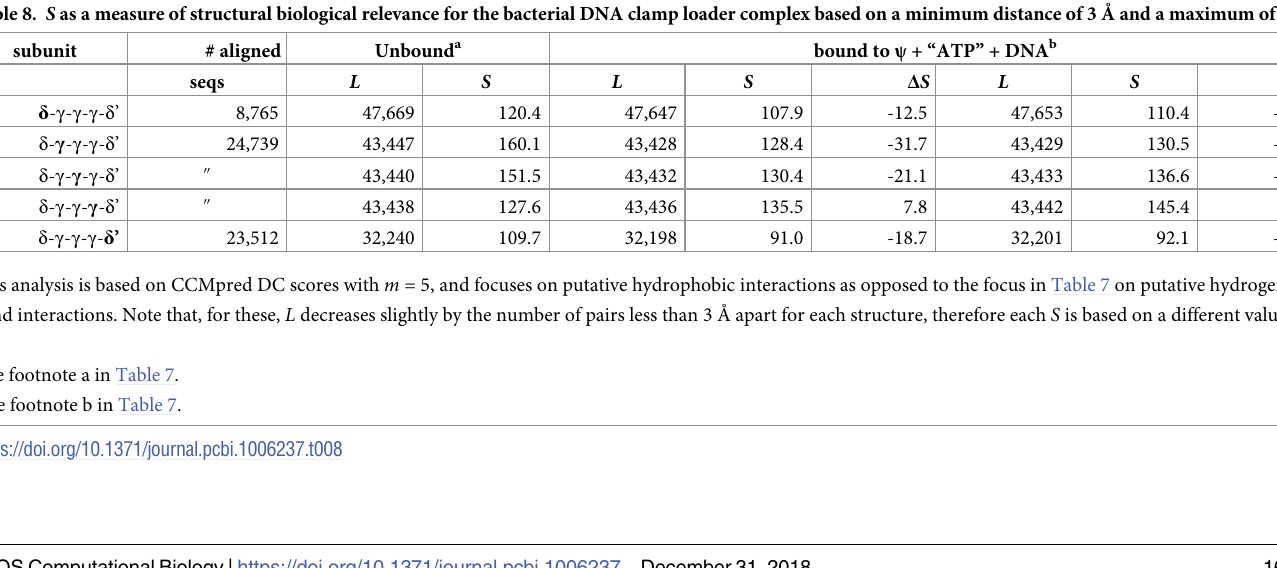
to the ψ protein and with an analog of ATP bound to each of the γ subunits (pdb_id: 3gli) [43]. First, using jackhmmer [45], we created one MSA for each of the subunits: δ , γ and δ ’, and used CCMpred to generate an ordered DCA array from each MSA. Second, we calculated val- ues of S for each array using corresponding structures for the δ , γ and δ ’ subunits ( Table 7 ). Note that in the bound form, there are two clamp loader complexes in the unit cell of the crys- tal structure, yielding two distinct structures for each of the five subunits. The difference between the s -scores for the bound and unbound forms, Δ S , ranges from 3 to 58 with a mean of 26, which is highly significant. This conforms to the expectation that the biologically more relevant bound conformation will yield higher S than the unbound form, and further illustrates how S can be used to evaluate a structure’s biological relevance. However, unlike for Gna1, the inclusion of contacts between adjacent γ subunits decreases S , suggesting that, in this case, homo-oligomer interactions fail to impose detectable constraints. Finally, we explored for clamp loader subunits the putative contributions to direct couplings of hydrogen bond interac- tions (pairwise distances � 2.6 Å ; Table 7) versus hydrophobic interactions (pairwise distances � 3 Å and � 5 Å ; Table 8 ). This comparison suggests that the biologically relevant clamp loader state favors presumably more geometrically specific hydrogen bond interactions over presumably less specific hydrophobic interactions.